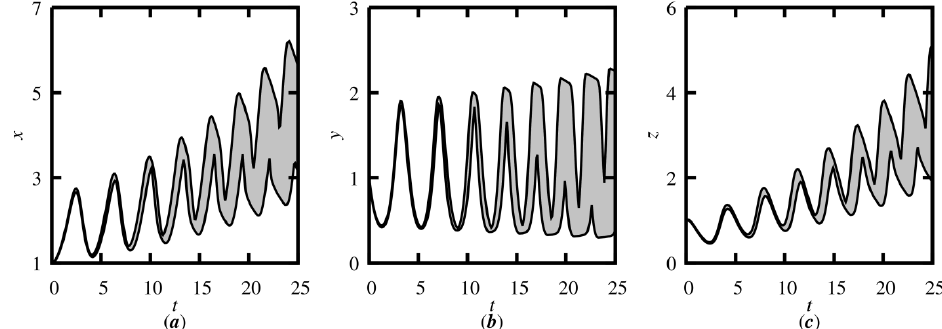
Figure 12. Time dependence of the upper and lower bounds for the solution of system given by Equation (11): ( a ) x ( t ) ; ( b ) y ( t ) ; ( c ) z ( t )